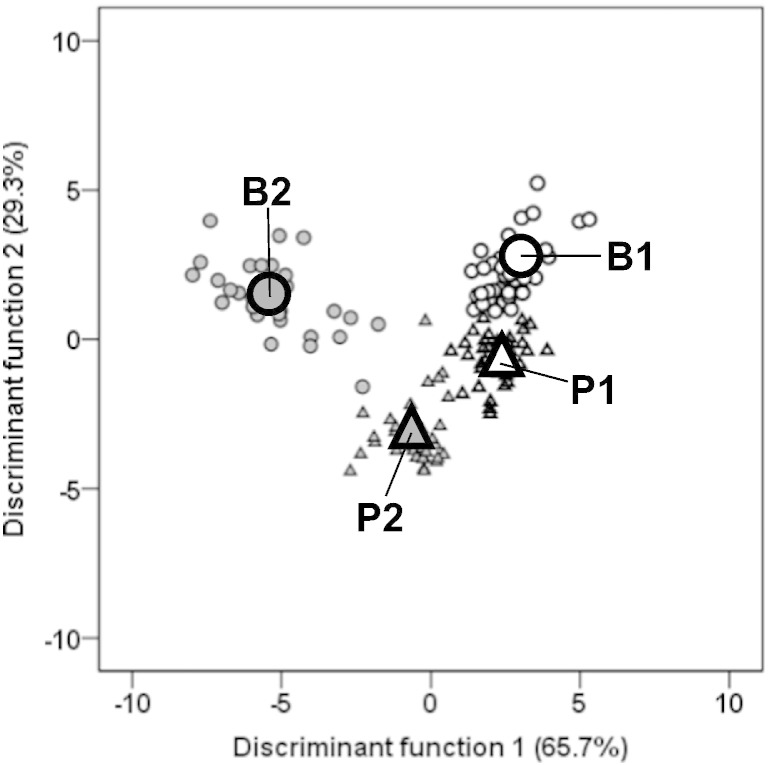
Discriminant analysis based on remaining contents of C, N, S, P, S, Ca, Mg, K, Na, Al, Fe and Mn, grouped by years of decomposition (1 year: outlined symbols; 2 years: filled symbols) and litter species (beech: circle; pine: triangle). Large symbols represent the respective group centroids: B1, B2 and P1, P2 (beech and pine after 1 and 2 years, respectively). The first two discriminant functions, ranked by percentage of explained variance (given in parenthesis), are given in Table 6.